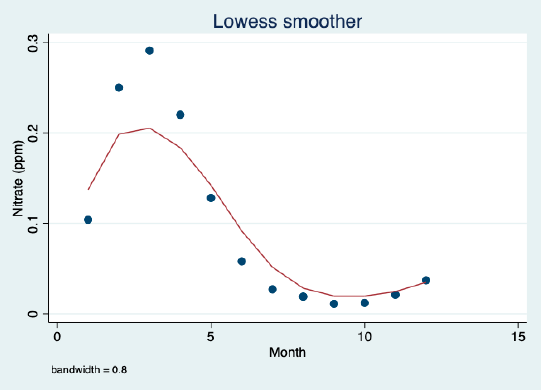
Figure 15. Lowess smoother (0.8 bandwidth) trend of changes plot of monthly changes of chloride concentration (ppm) (left) and salt loads (10 3 tons) (right) (1969–2001).